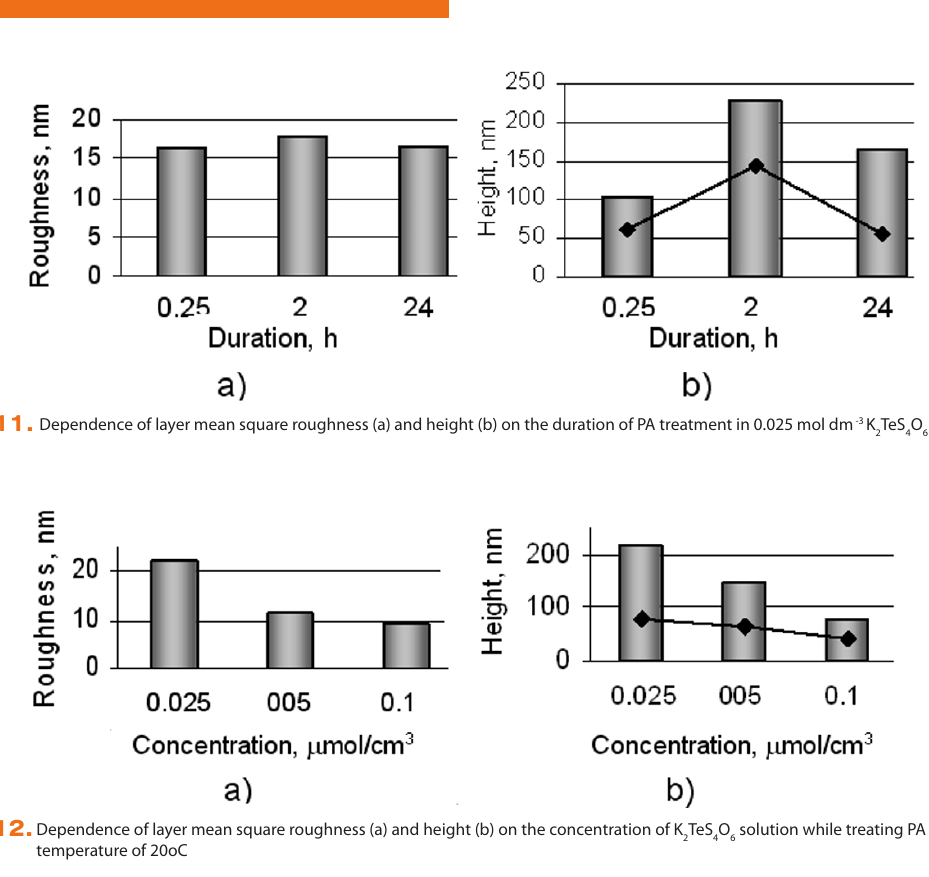
TeS O solution while treating PA in for 8 h at a 2 4 6